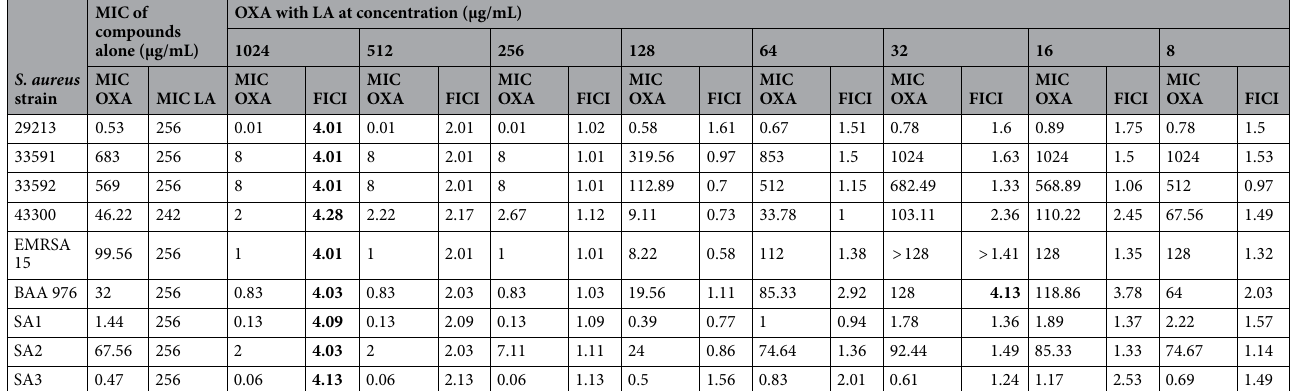
Table 3. Combinatory effect of lauric acid and oxacillin against Staphylococcus aureus determined by checkerboard method. Data are presented as average of three analyses, each performed in